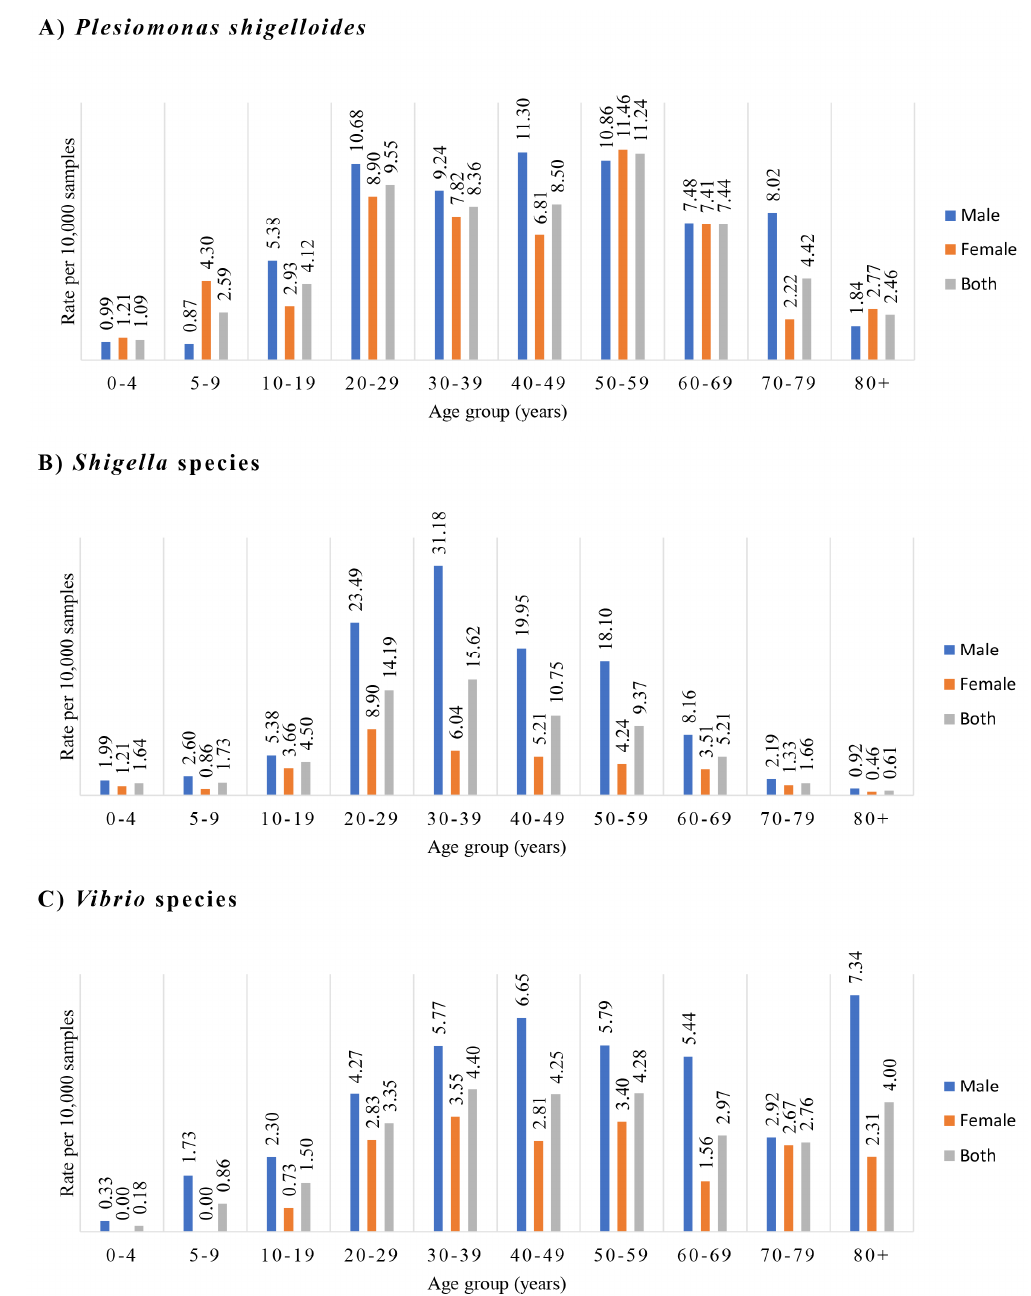
Figure 2. Isolation of Plesiomonas shigelloides , Shigella species and Vibrio species during 2015–2019 from different age groups and gender. The bacterial pathogens were isolated from faecal samples of patients with gastroenteritis. The isolation rates were the positive isolations per 10,000 samples. ( A ) P. shigelloides , ( B ) Shigella species and ( C ) Vibrio species. The isolations of P. shigelloides , Shigella and Vibrio species were more common during human adult life between 20 to 59 years old. The isolation rate of Shigella species was significantly higher in male patients than female patients, p < 0.001). The isolation rate of Vibrio species was positively associated with age ( p < 0.001) and significantly higher in male patients than female patients ( p < 0.001). Table 4. Isolation of Plesiomonas shigelloides , Shigella and Vibrio species in individual years, from 2015 to 2019, in different age groups. Plesiomonas Positive Case Shigella Positive Case